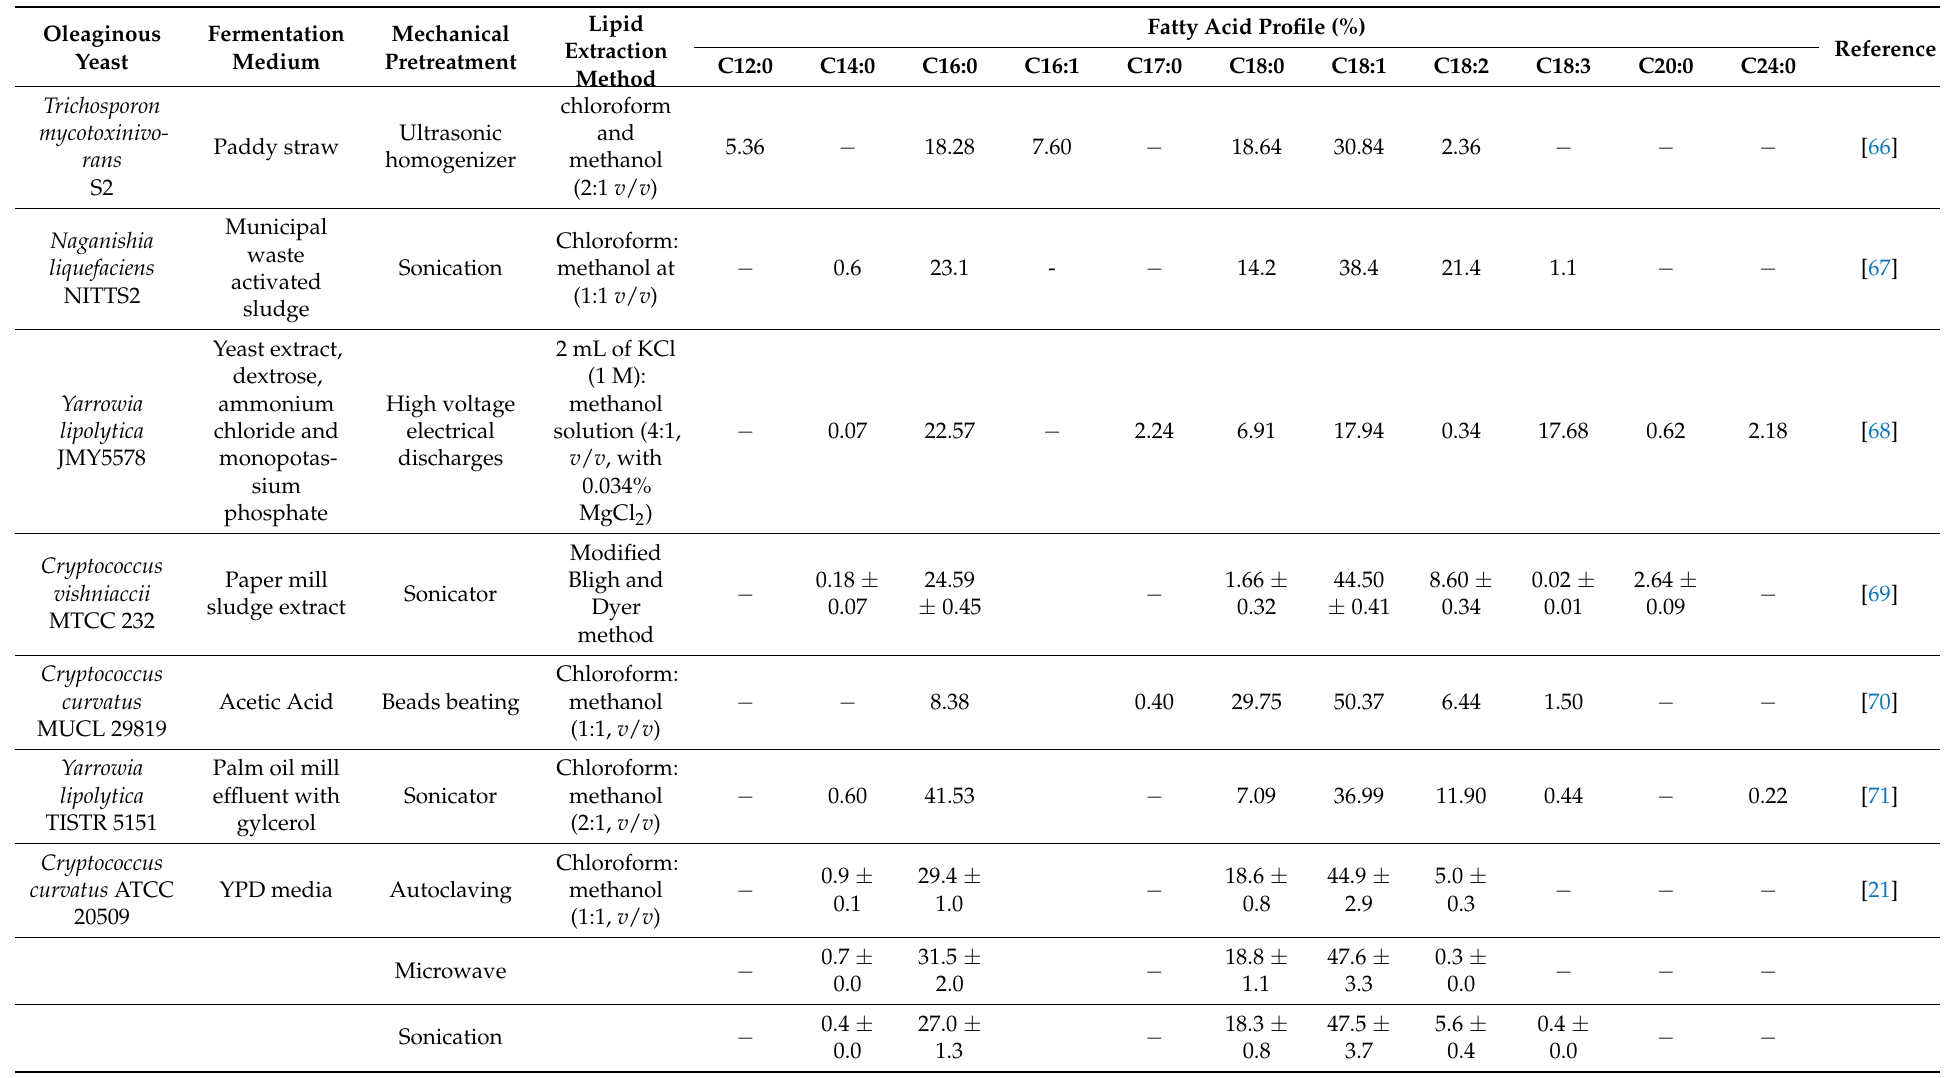
Table 1. Fatty acid profile of oleaginous yeasts extracted using various mechanical pretreatment/cell disruption and lipid extraction